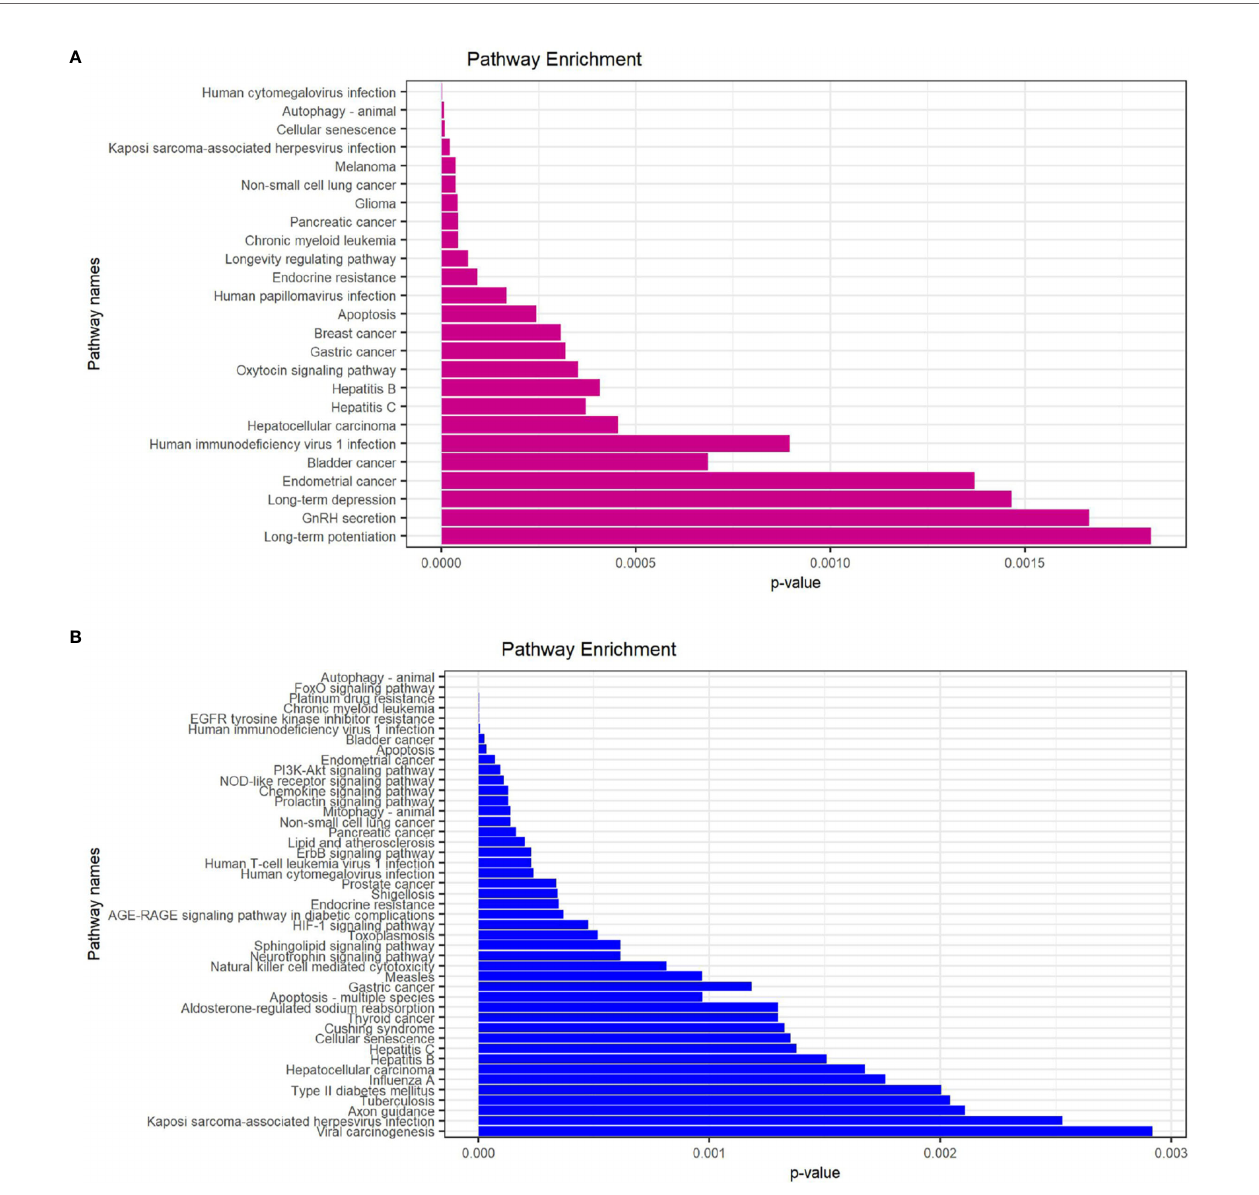
FIGURE 6 | KEGG enrichment analysis of 23 differentially expressed autophagy-related genes. (A) , KEGG analysis of 9 up-regulated expressed autophagy-related genes. (B) , KEGG analysis of 14 down-regulated expressed autophagy-related genes. KEGG, Kyoto Encyclopedia of Genes and